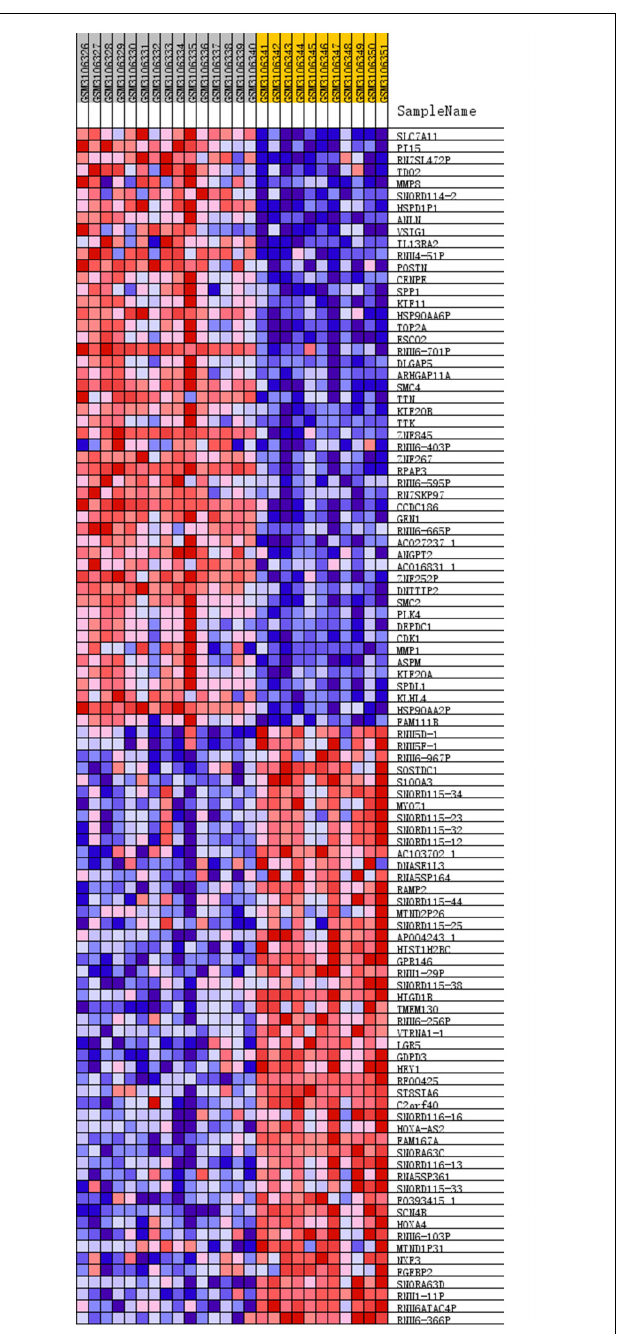
FIGURE 1 | Heatmap of top 50 features for each phenotype. The PAH group: GSM3106326 – GSM3106340, and the normal lung tissue group: GSM3106341 – GSM3106351. Removed duplicate probes in GSE113439 and identified a total of 23,410 genes. Among these, 5,525 genes showed differences in expression between PAH tissues and healthy lung tissues. The expression of 3,964 genes was increased in PAH tissues, while 1,291 genes were upregulated in healthy lung tissues. The heatmap showed the two groups of genes that were in the top 50 for upregulation or downregulation. Red indicates that the gene expression is up-regulated, while blue indicates that the gene expression is down-regulated. In the same color, the darker the color, the more significant it